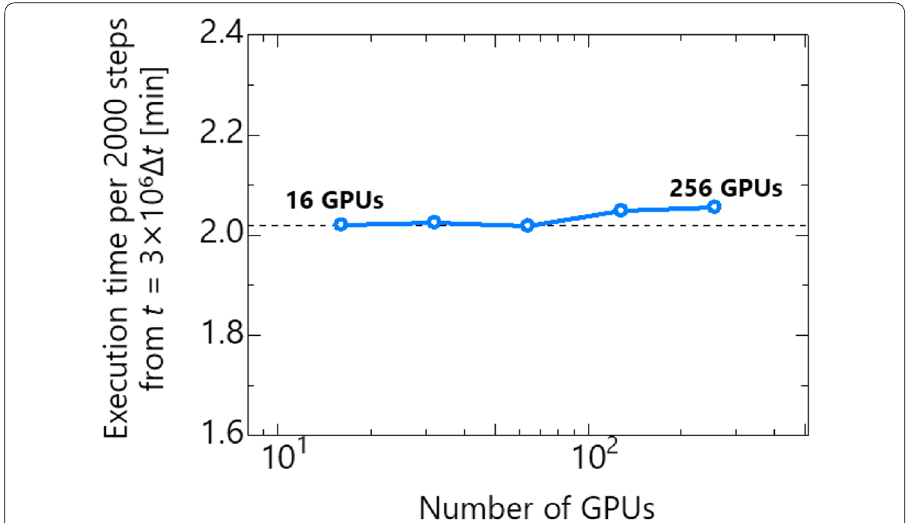
Fig. 9 Weak scaling test results of AMR-PF computation with multiple GPUs using the distributions shown in Fig.